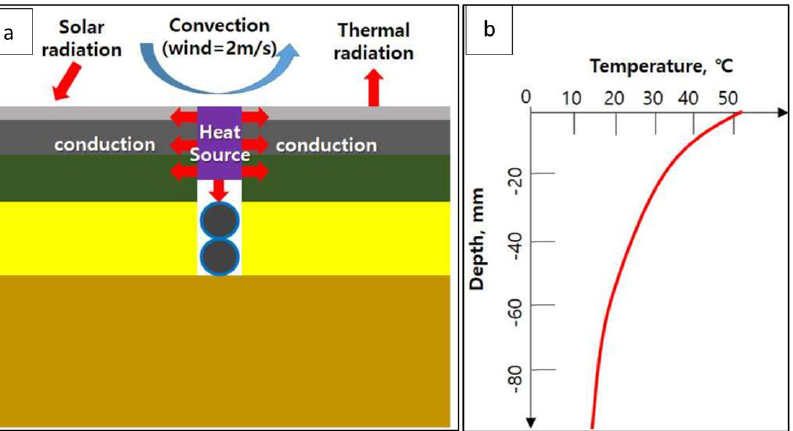
Figure 4. Initial and boundary conditions. ( a ) The transmitting of heat source; ( b ) the relationship between temperature and